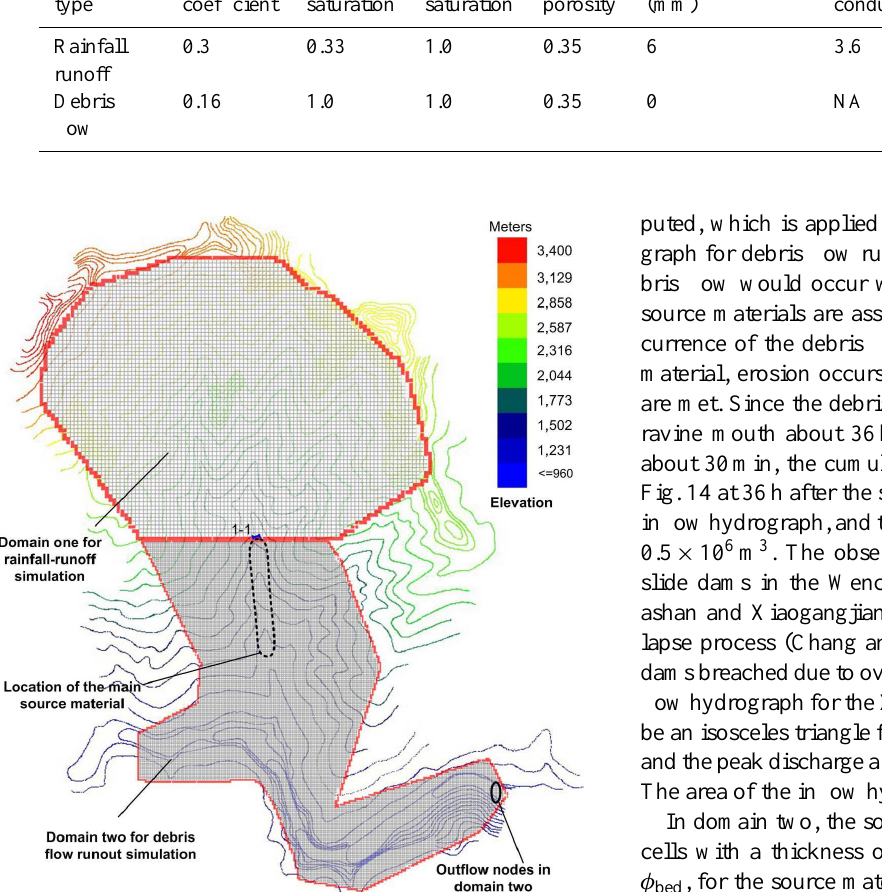
Table 1. The values of α 1 , β 1 , α 2 , β 2 , K , and n are